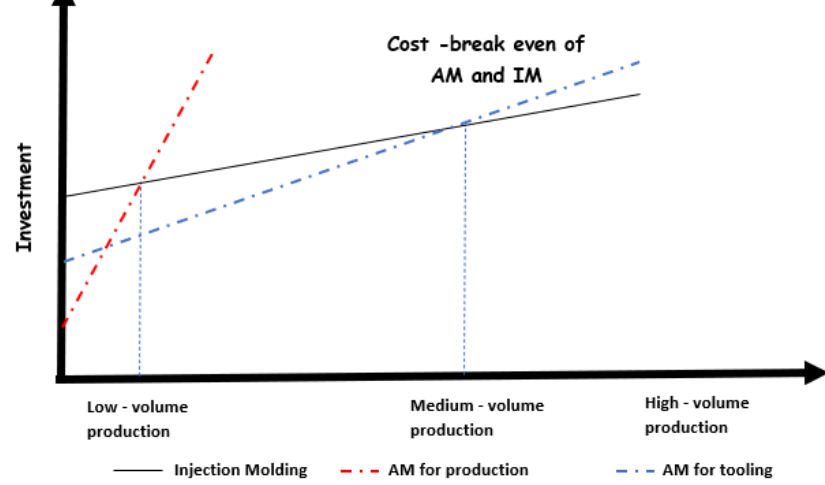
Figure 7. Cost curves of IM, AM for production, and AM for tooling.